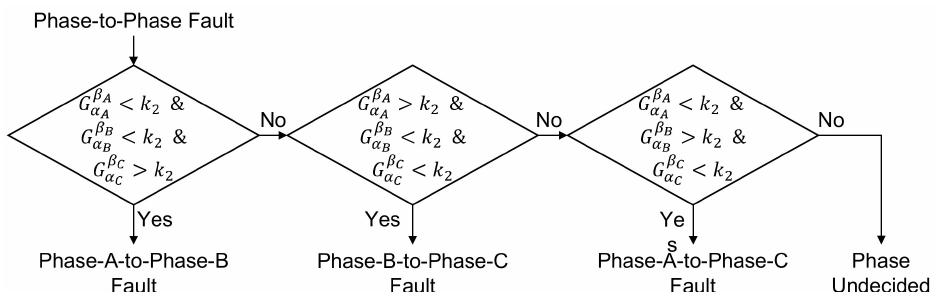
Figure A3. Phase-to-Phase faults identification